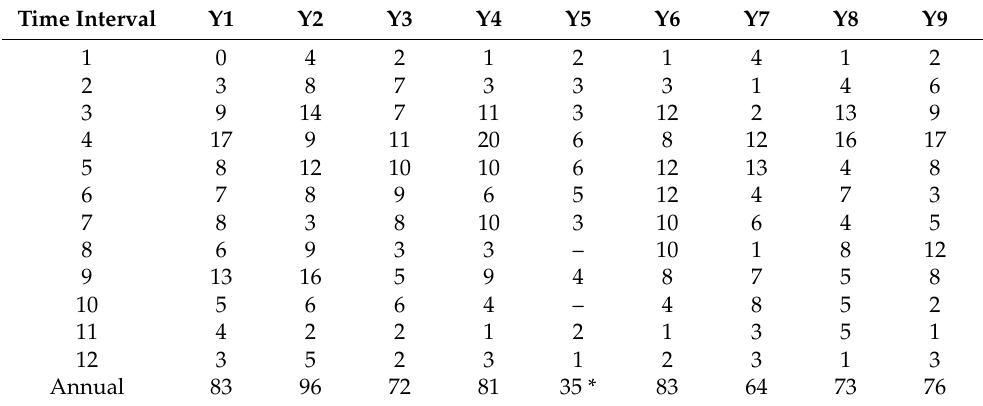
Table 2. Number of new particle formation event days in each month and over the whole measure- ment years Y1 to